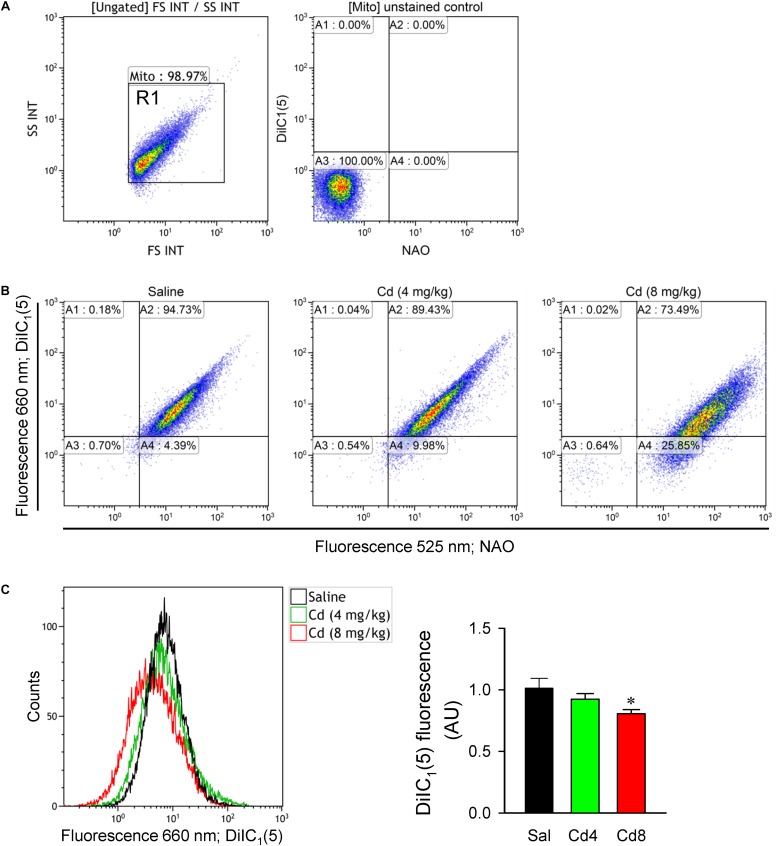
Estimation of mitochondrial membrane potential from freshly isolated mitochondria of RVLM tissue. (A) Mitochondria were gated based on light scattering properties in the FS and SS modes by 20,000 events for each sample within the gate R1. Unstained control sample shown fluorescence at 525 and 660 nm for the events within R1. (B) Representative dot plots from a double-staining using 100 nM NAO (mitochondrial marker) and 10 nM DiIC1(5) (mitochondrial membrane potential indicator). (C) Representative histogram or quantification of mean intensity of fluorescence at DiIC1(5) (660 nm) from mitochondria in rats that received saline, 10 min after cadmium (Cd; 4 mg/kg, iv), or died from Cd (8 mg/kg, iv). Values are mean ± SEM, n = 5–6 animals per experimental group. *P < 0.05 vs. saline (sal) group in the post hoc Tukey test.